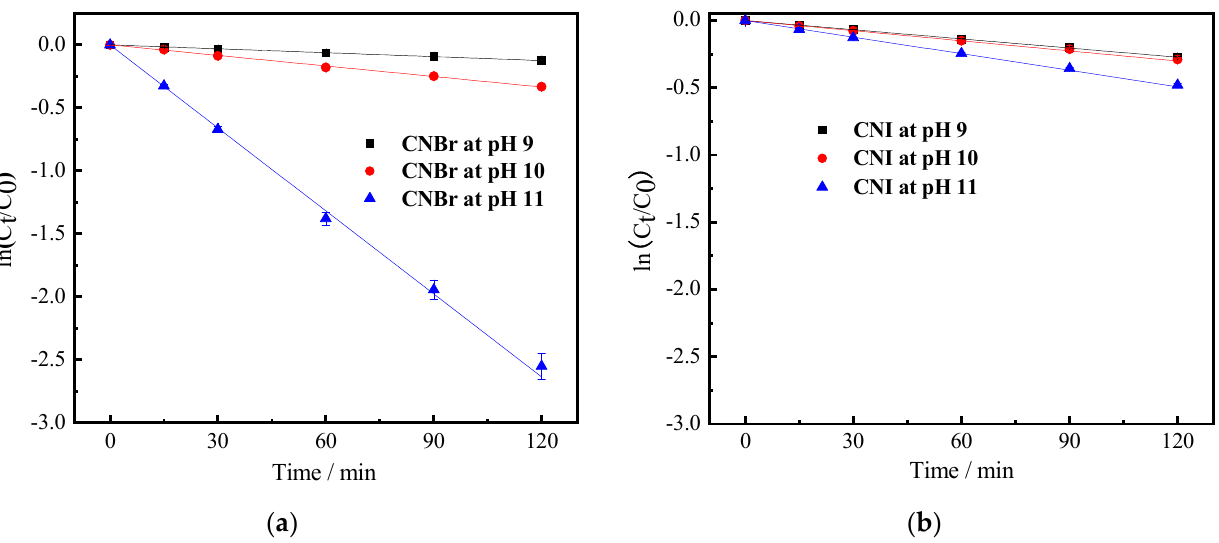
Figure 4. Hydrolysis of CNBr ( a ) and CNI ( b ) at different pH values ([CNBr] 0 = 100 μg/L, [CNI] 0 = 150 μg/L).